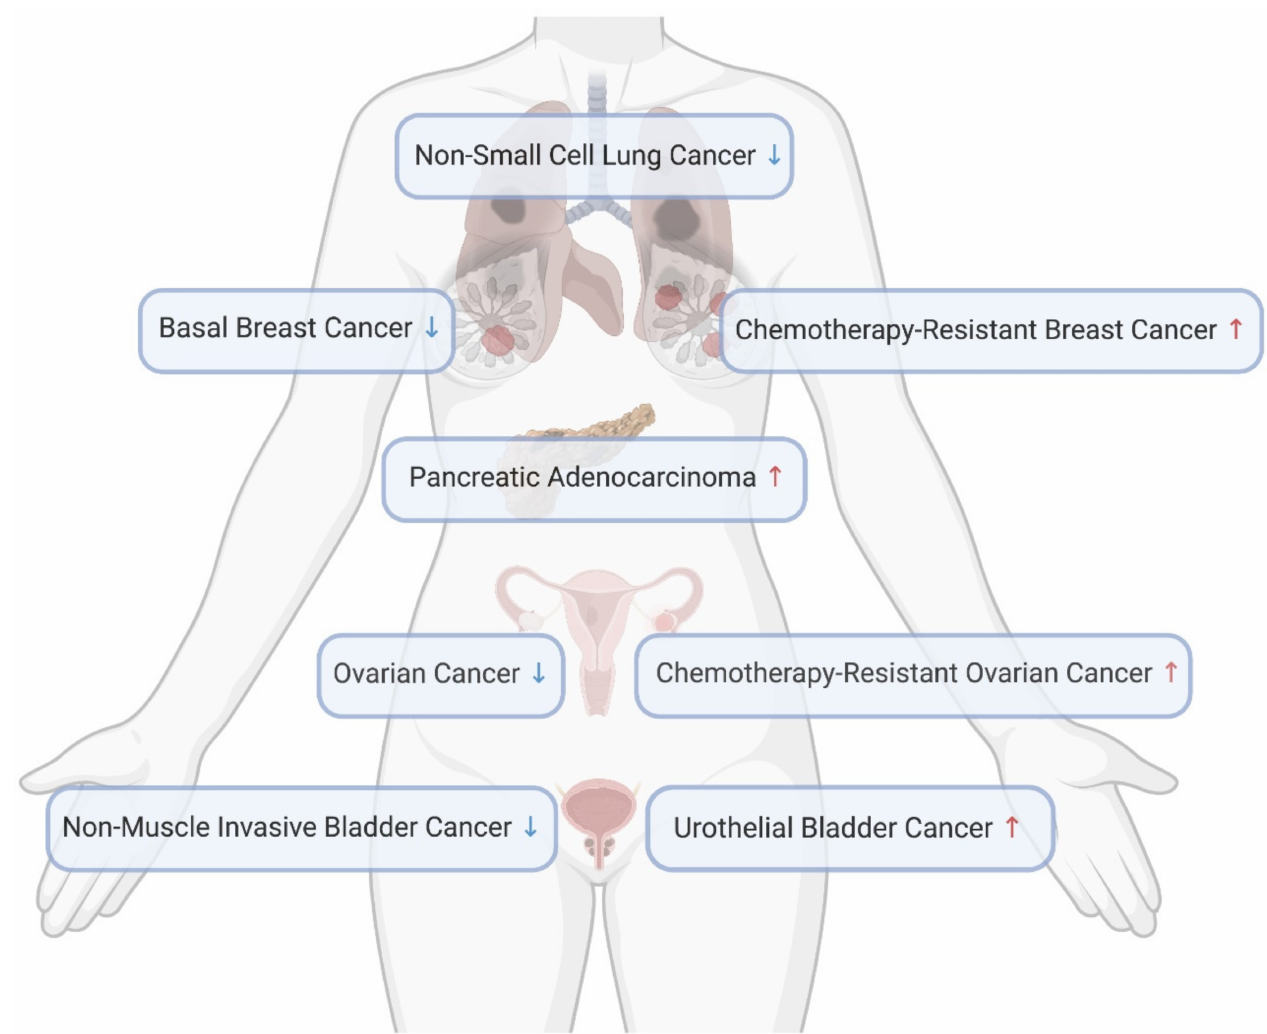
Figure 5. CERT level changes in cancers. Created in Biorender.com (accessed on 11 November